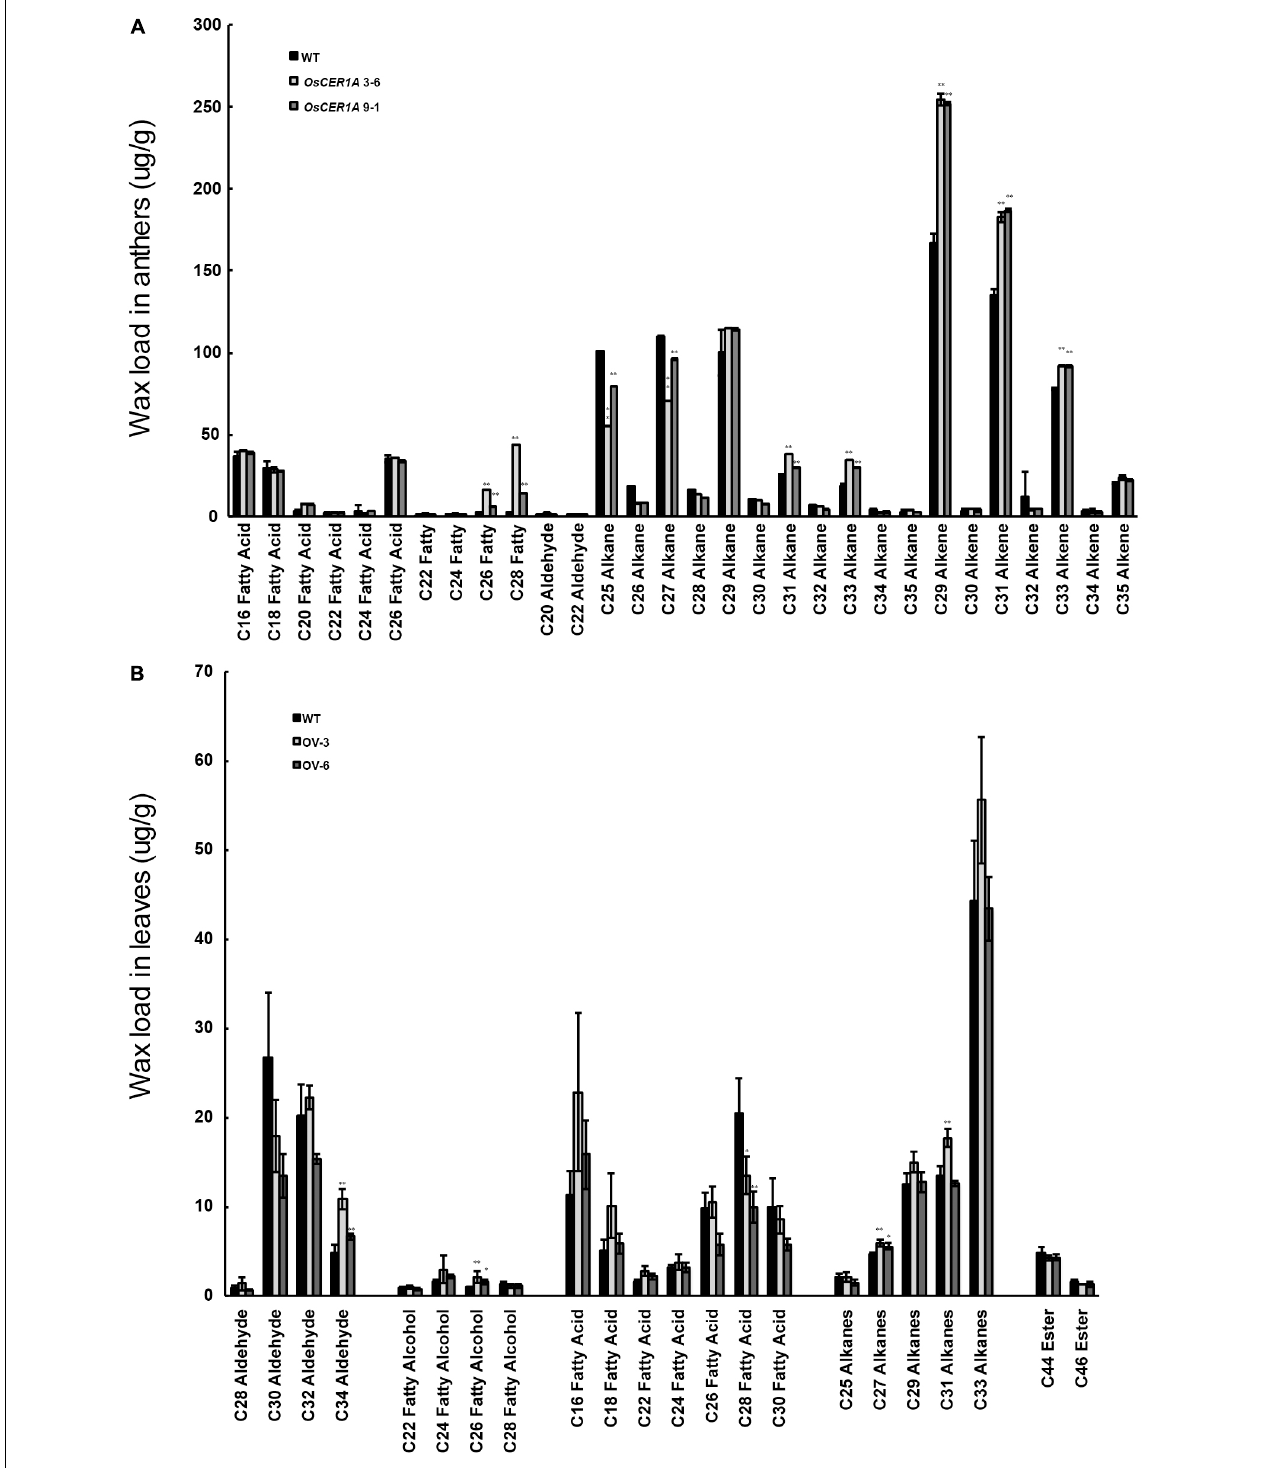
FIGURE 8 | Analysis of wax constituents. (A) Wax constituents in whole anthers at stage 12 in the WT (Black bars), OsCER1A 3-6 (slightly gray bars) and OsCER1A 9-1 (darkly gray bars) plants. (B) Wax constituents in leaves in the WT (black bars), OsCER1 overexpression 3 (OV-3) (slight gray bars) and OsCER1 overexpression 6 (OV-6) (darkly gray bars) plants. Error bars indicate SD ( n = 5). Statistical significance of differences between WT and transgenic plants means is indicated by ∗ p < 0.05 and ∗∗ p <